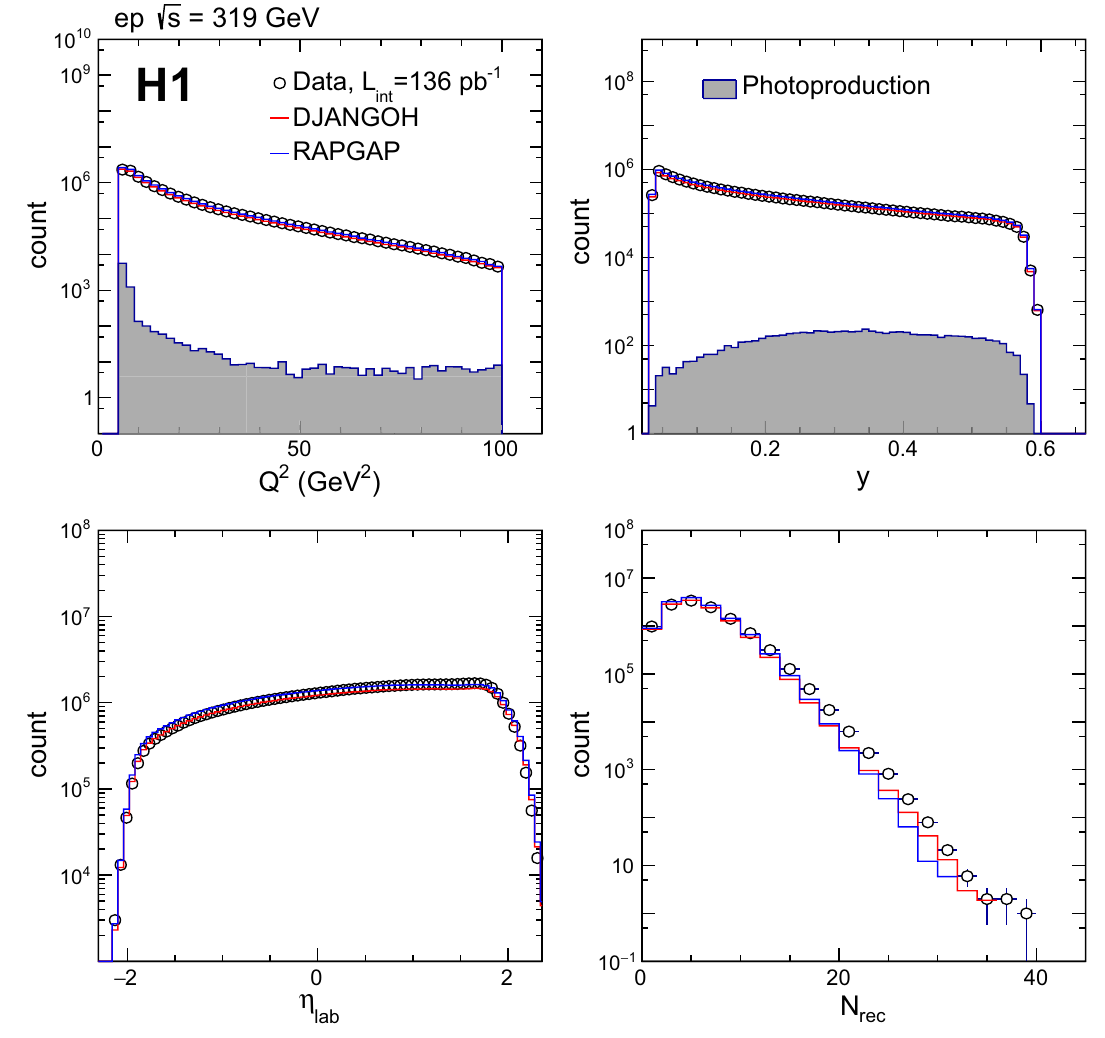
Fig. 1 Reconstructedmomentumtransfer Q 2 ,inelasticity y ,pseudora- pidity η , and charged particle multiplicity N rec for data (open circle), lab and the DJANGOH (red line) and the RAPGAP (blue line) MC models.